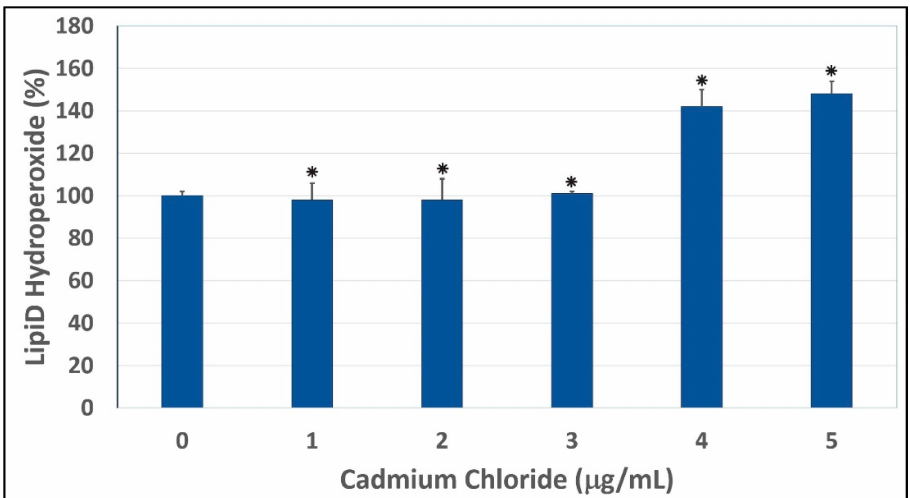
Figure 2. Cadmium chloride-induced lipid peroxidation in human liver carcinoma (HepG 2 ) cells. Cells were incubated for 48 h with increasing concentrations of cadmium chloride (1, 2, 3, 4, and 5 µ g/mL). Lipid hydroperoxide levels were determined as described in Materials and Methods. * Significantly different ( p < 0.05) from the control, according to the Dunnett’s test. Data are representative of three independent